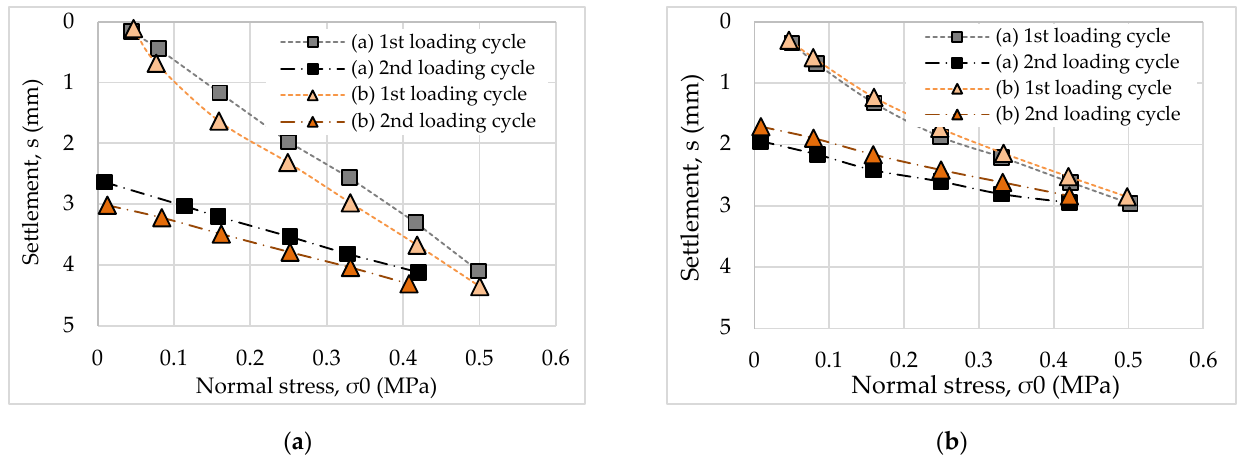
Figure 12. PLT results for two tests (a and b) of the first and second loading cycle: ( a ) unreinforced pavement; ( b ) reinforced pavement.